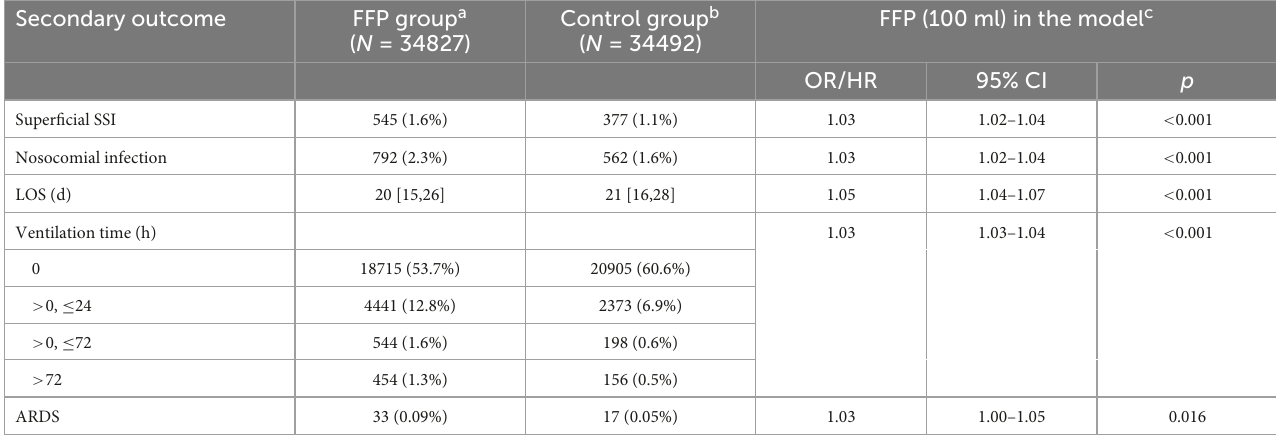
TABLE 3 Analysis of the secondary outcomes.